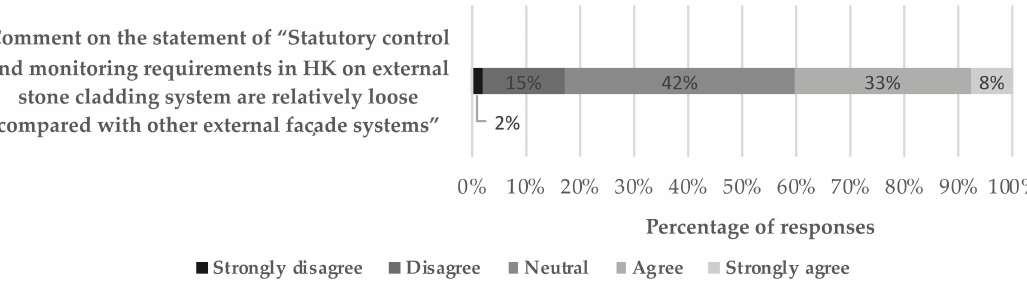
Figure 4. Comment on the statement of “Statutory control and monitoring requirements in Hong Kong on the external stone cladding system are relatively loose compared with other external façade systems” ( n = 53).